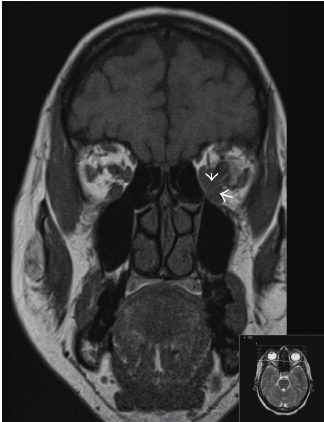
Figure 5: T1 weighted MRI orbits show soft tissue replacing fat in the medial left orbit is isointense with the adjacent recti and it is suggestive of a soft tissue deposit (white